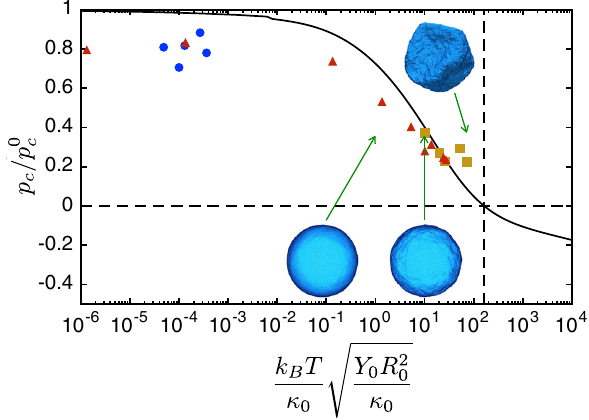
FIG. 5. Thermal fluctuations reduce critical buckling pressure p below its classical value p 0 in Eq. (10), to a point where it can ffiffiffiffiffiffiffiffiffiffiffiffiffiffiffiffiffi p c c ≫ 1 . The T= κ 0 Þ Y 0 R 2 0 = κ 0 even assume negativevalues when ð k B solid black line corresponds to the theoretical prediction based on renormalization group calculations and symbols are buckling transitions extracted from the Monte Carlo simulations of Ref. [75]. Green arrows point to the locations in parameter space p ffiffiffiffiffiffiffiffiffiffiffiffiffiffiffiffiffi Y 0 R 2 0 = κ 0 and p 0 =p 0 , that correspond to the snapshots ð k B T= κ 0 Þ c of spherical shells from the simulations shown in Fig. 1. Because for large temperatures T (or equivalently for large shells R 0 ) the critical buckling pressure p becomes negative, thermal fluctua- c tions spontaneously crush spherical shells even at zero or some- what negative external